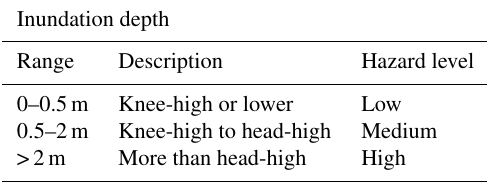
Table 1. Hazard level according to flow